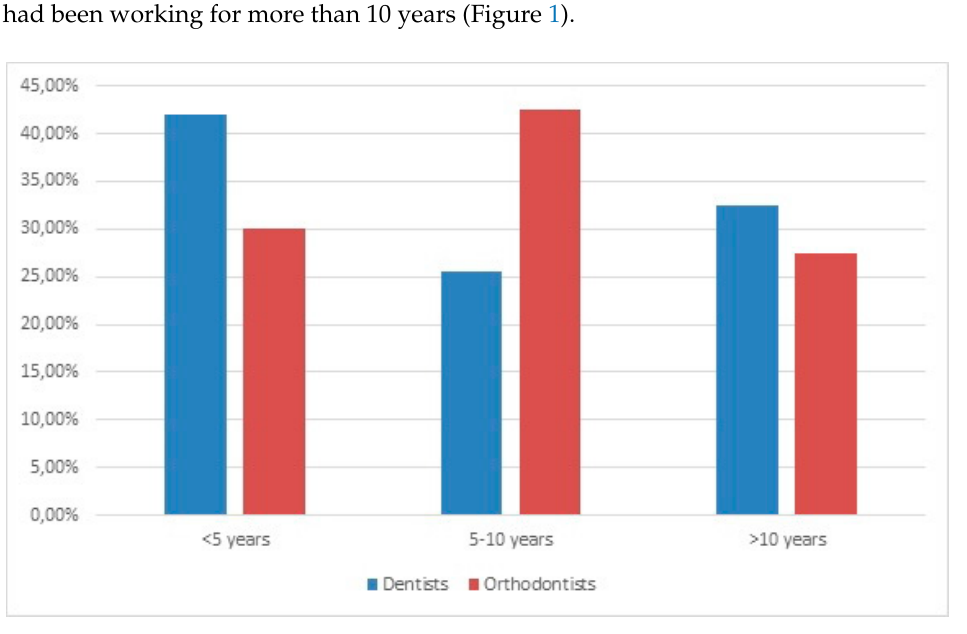
Figure 1. Distribution of respondents’ work experience.